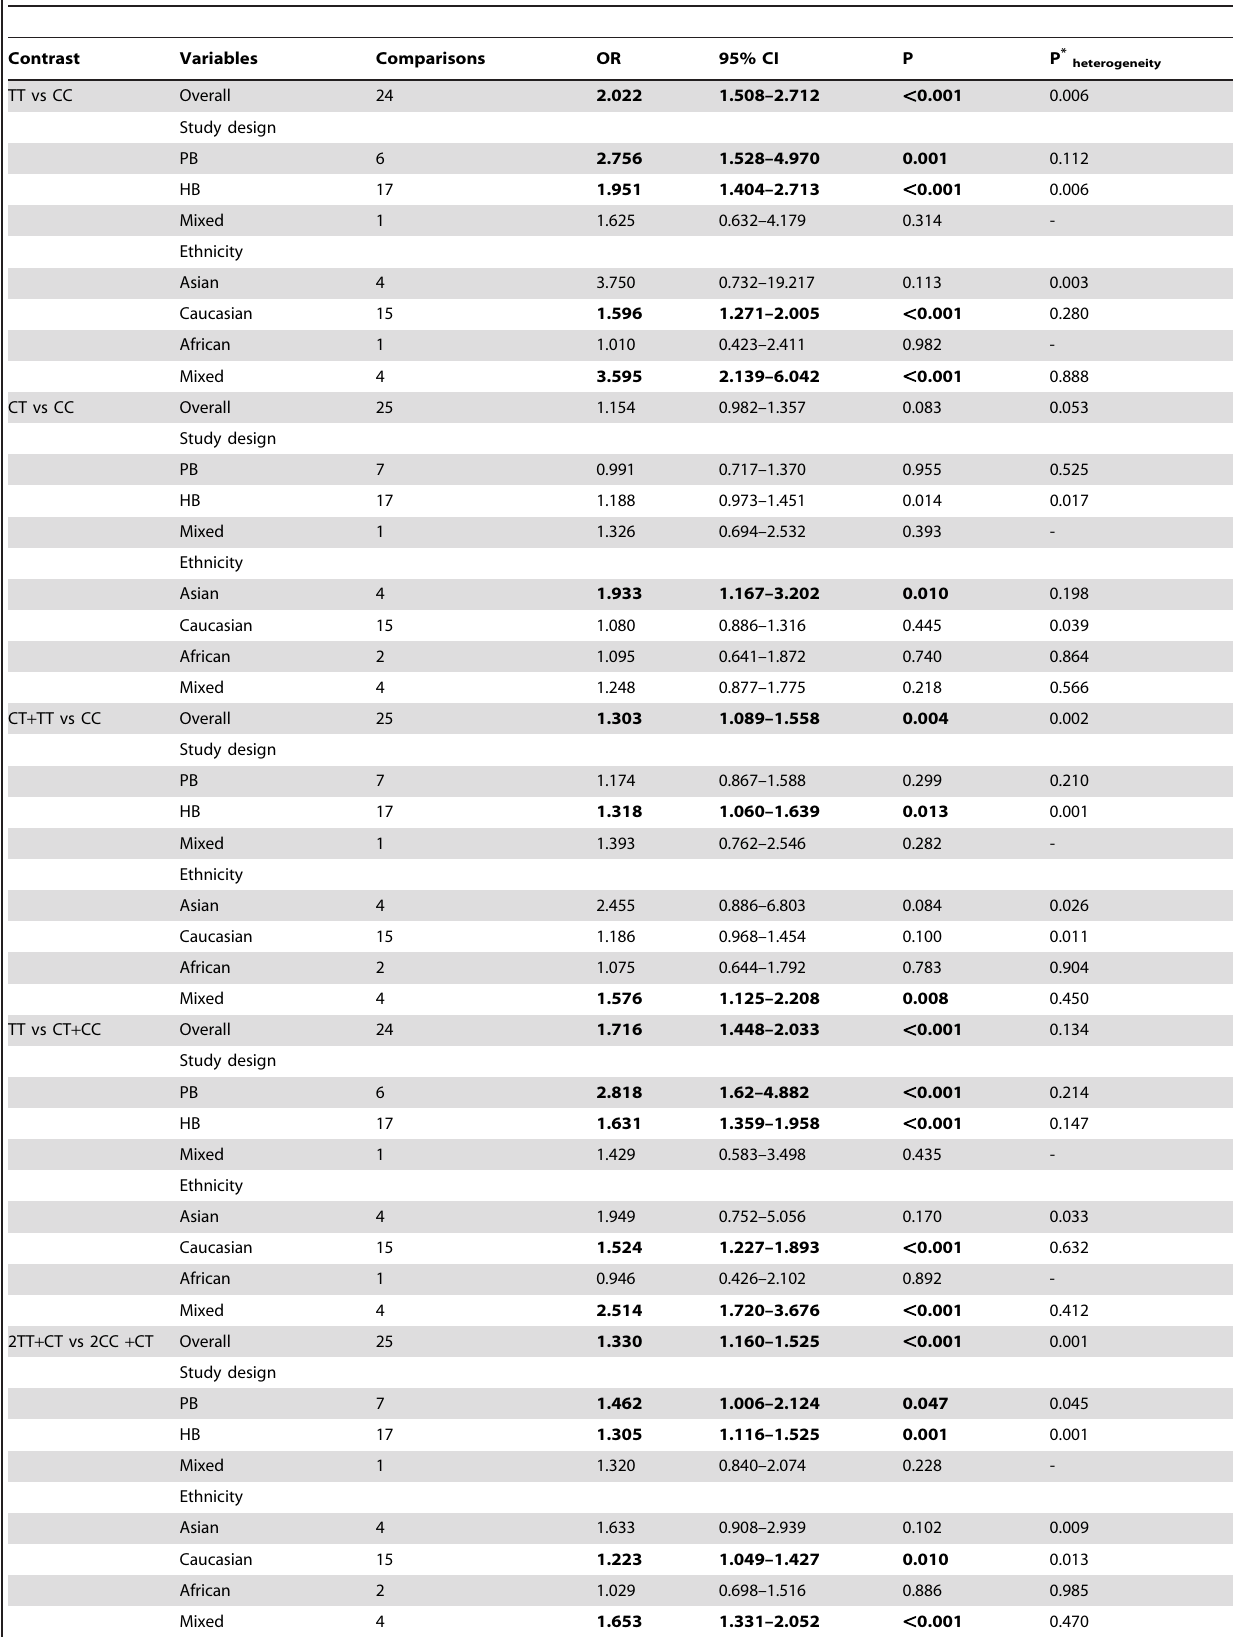
Table 2. Summary of comparisons for maternal MTHFRC677T polymorphism and risk of Neural tube defects (NTDs).